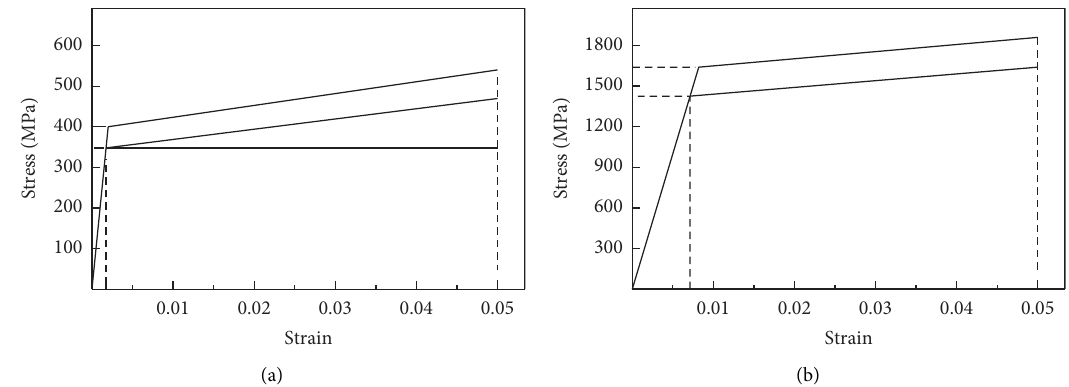
Figure 10: Material curves of axial steels according to Eurocode 2. (a) Reinforcement. (b) Tendon.